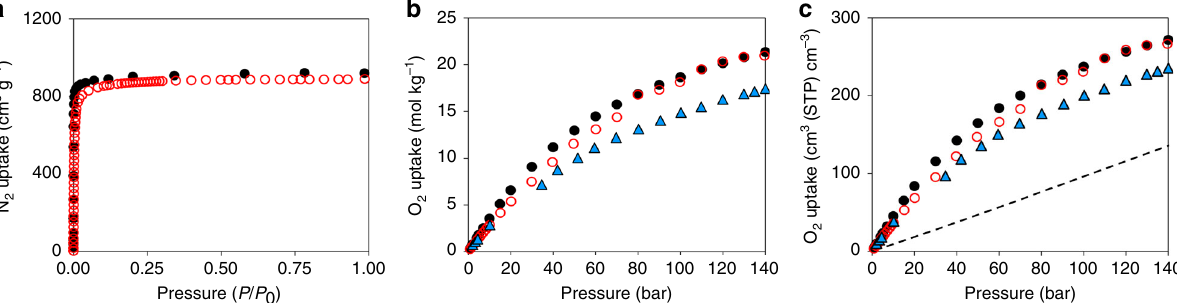
Fig. 3 Comparison of experimental and simulated nitrogen and oxygen uptake for UMCM-152. a Nitrogen adsorption isotherms obtained at 77 K: black circles, simulation; red open circles, experiments. b gravimetric and c volumetric oxygen adsorption isotherms at 298 K. The experimental isotherms for NU-125 are included for comparison (blue triangles) 20 . The dashed line indicates adsorption in an empty tank at 298